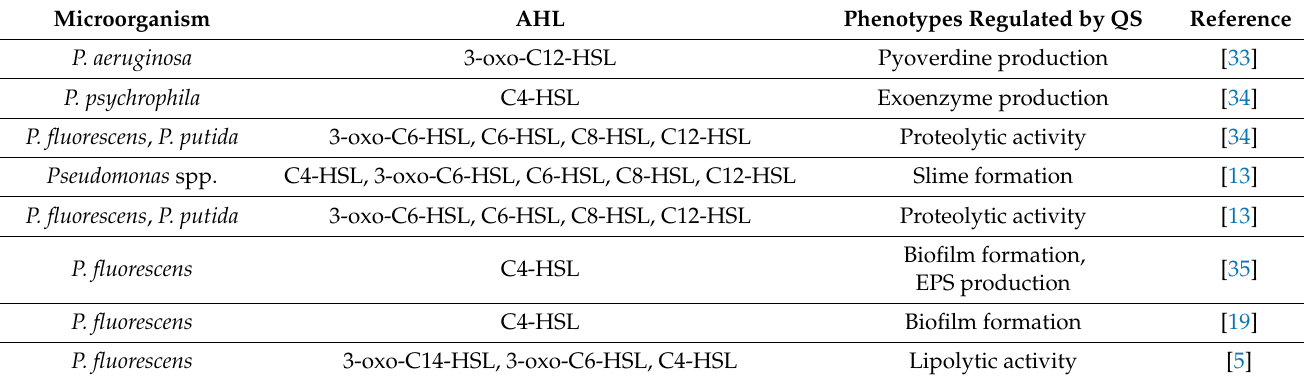
Table 1. Examples of Pseudomonas spp. phenotypes regulated by AHLs-mediated